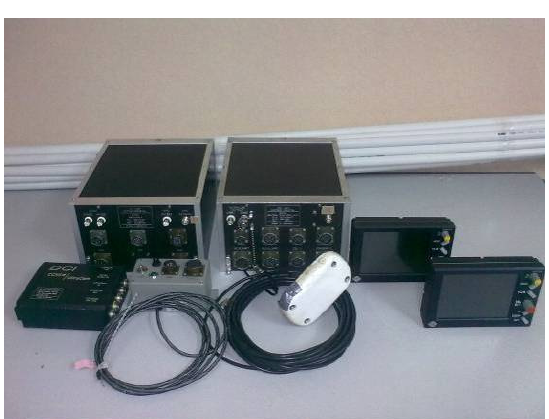
Figure 1. CCNS4 & AEROcontrol